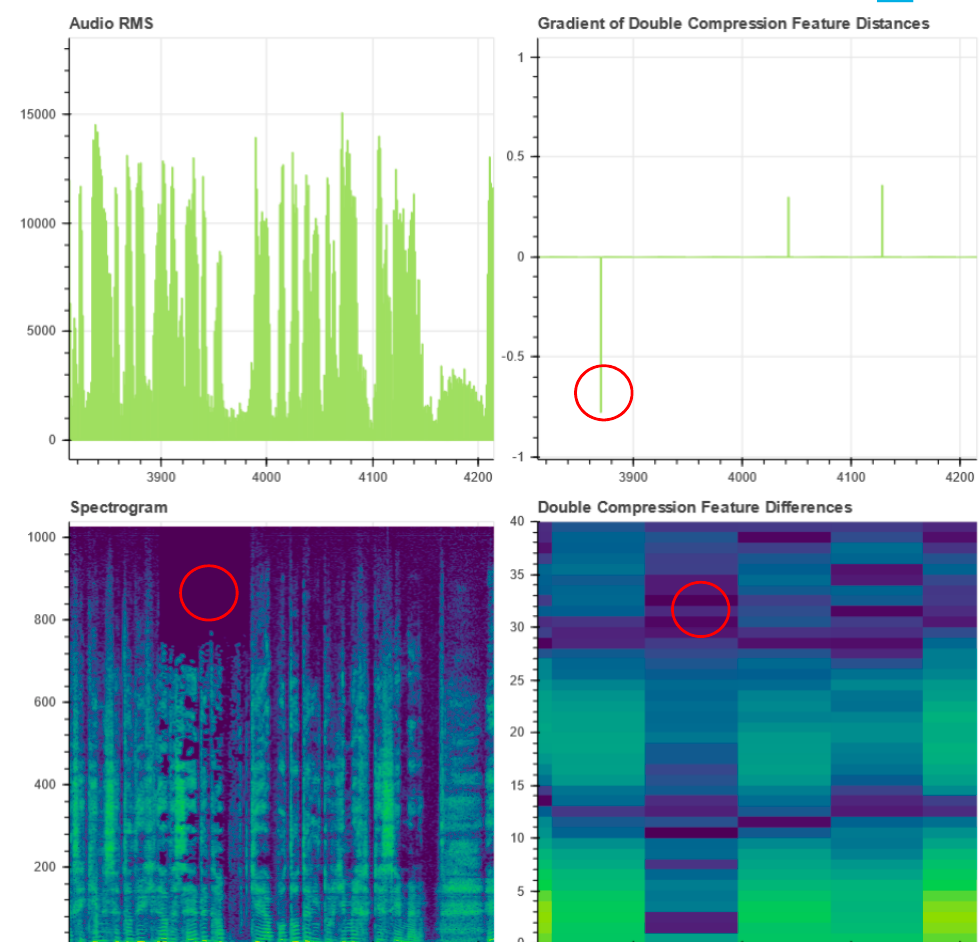
Figure 3. An example of combined analysis. The user has zoomed in at a suspicious point in time, and three of the visualizations indicate forgery.